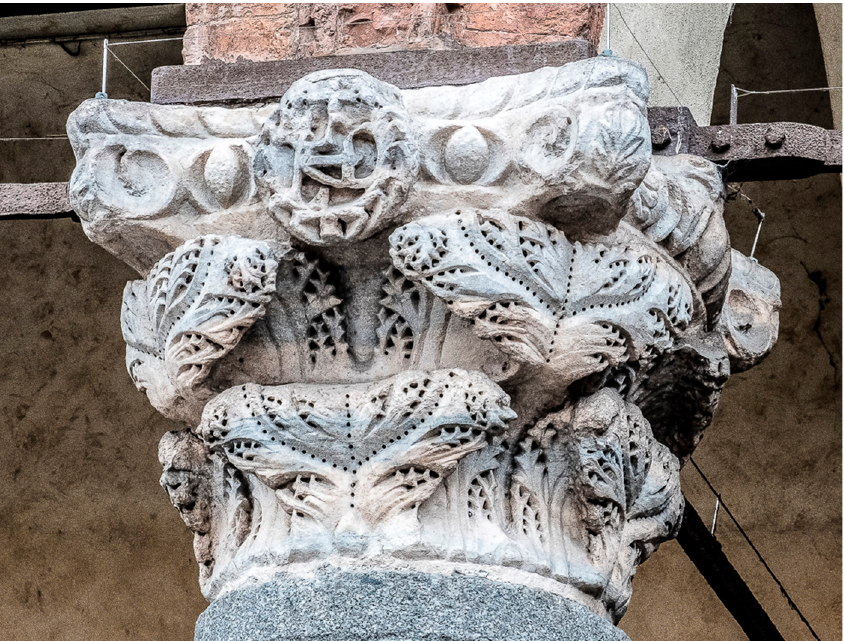
Figure 4. Capital with Theoderic’s monogram on the abacus, Piazza del Popolo, Ravenna (photo: M. Benfatti).